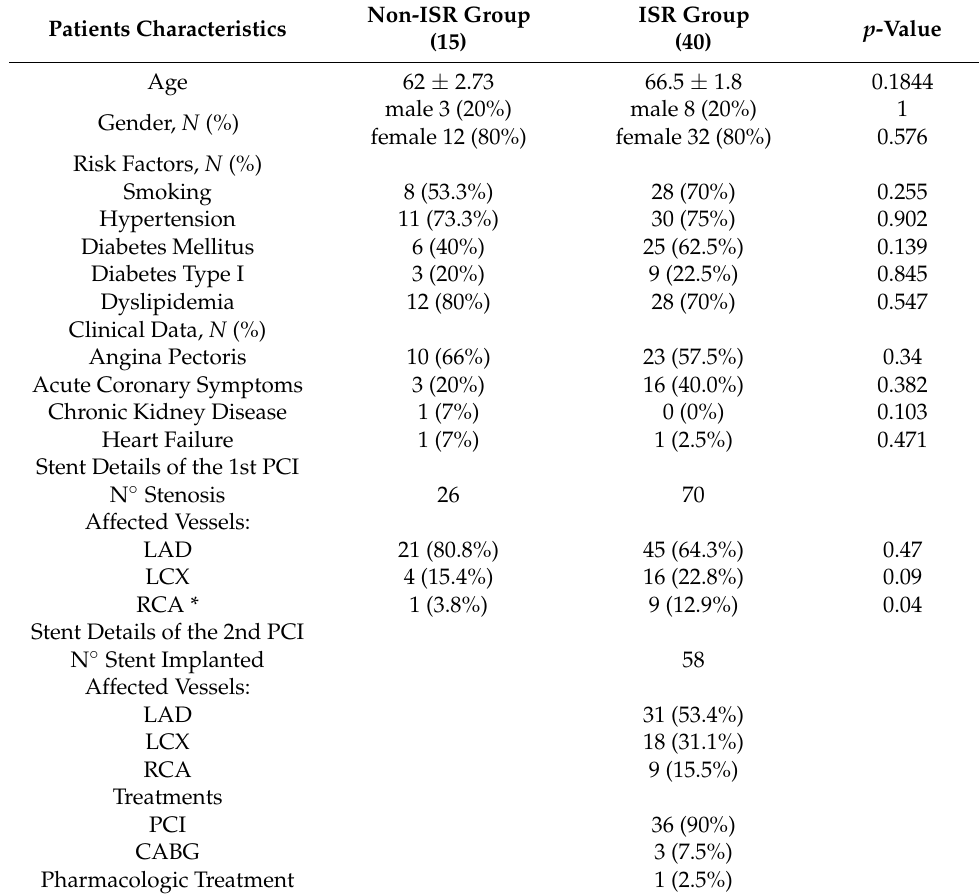
Table 1. Data summary (number and percentage) of the patient characteristics. ISR indicates intra- stent restenosis. The other terms are acute coronary symptoms (ACS), coronary artery bypass grafting (CABG), left anterior descending (LAD), left circumflex artery (LCX), right coronary artery (RCA), and percutaneous coronary intervention (PCI). * indicates significant values at p < 0.05. Patients